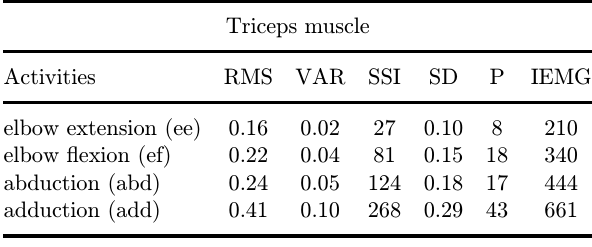
Table 3. Feature extracted values for triceps muscle.